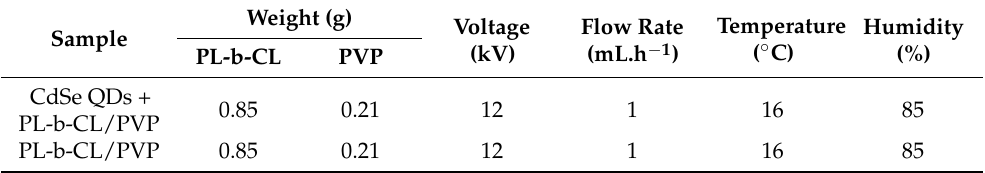
Table 1. The electrospinning parameters of nanofibers.